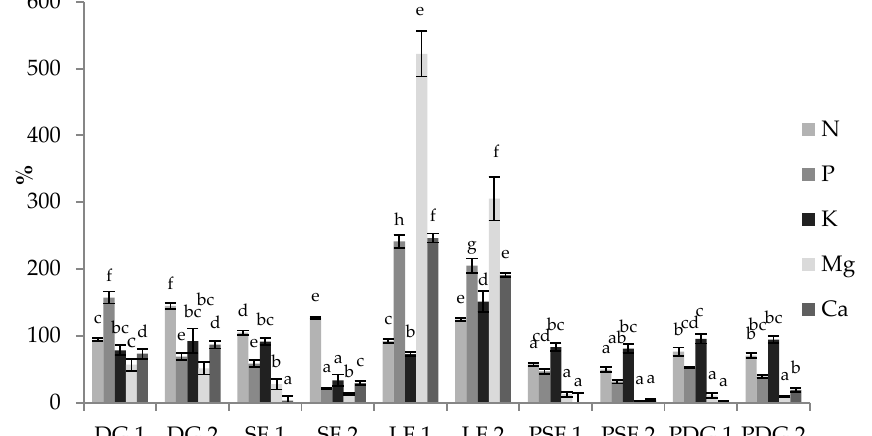
Figure 3. Apparent macronutrients recovery (ANR) from different forms of digestate. The standard deviation within each treatment ( n = 3) is indicated by the line extending the column. Values followed by the same letters in the column (separately for nutrients) are not statistically different ( p < 0.05).